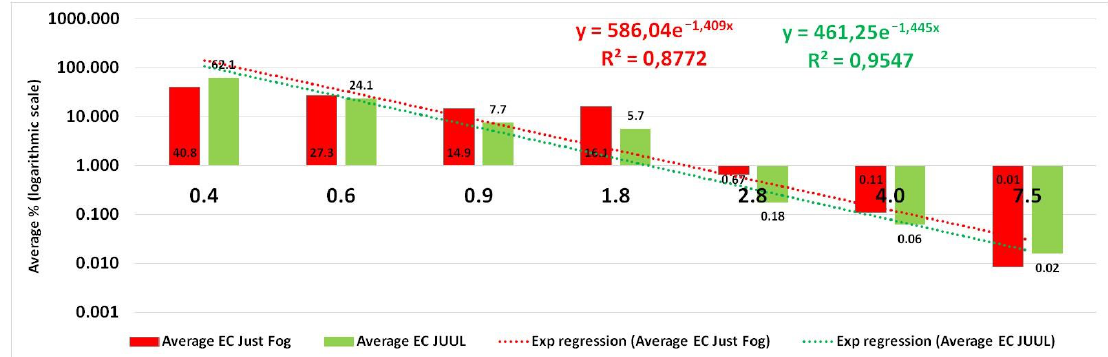
percentages (see Figure 8).